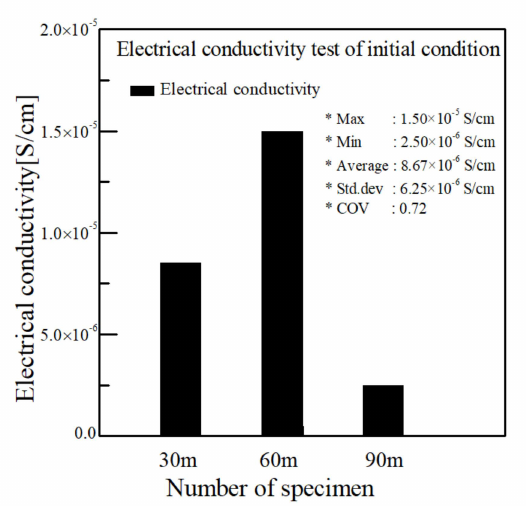
Figure 6. This is a figure. Schemes follow the same formatting.